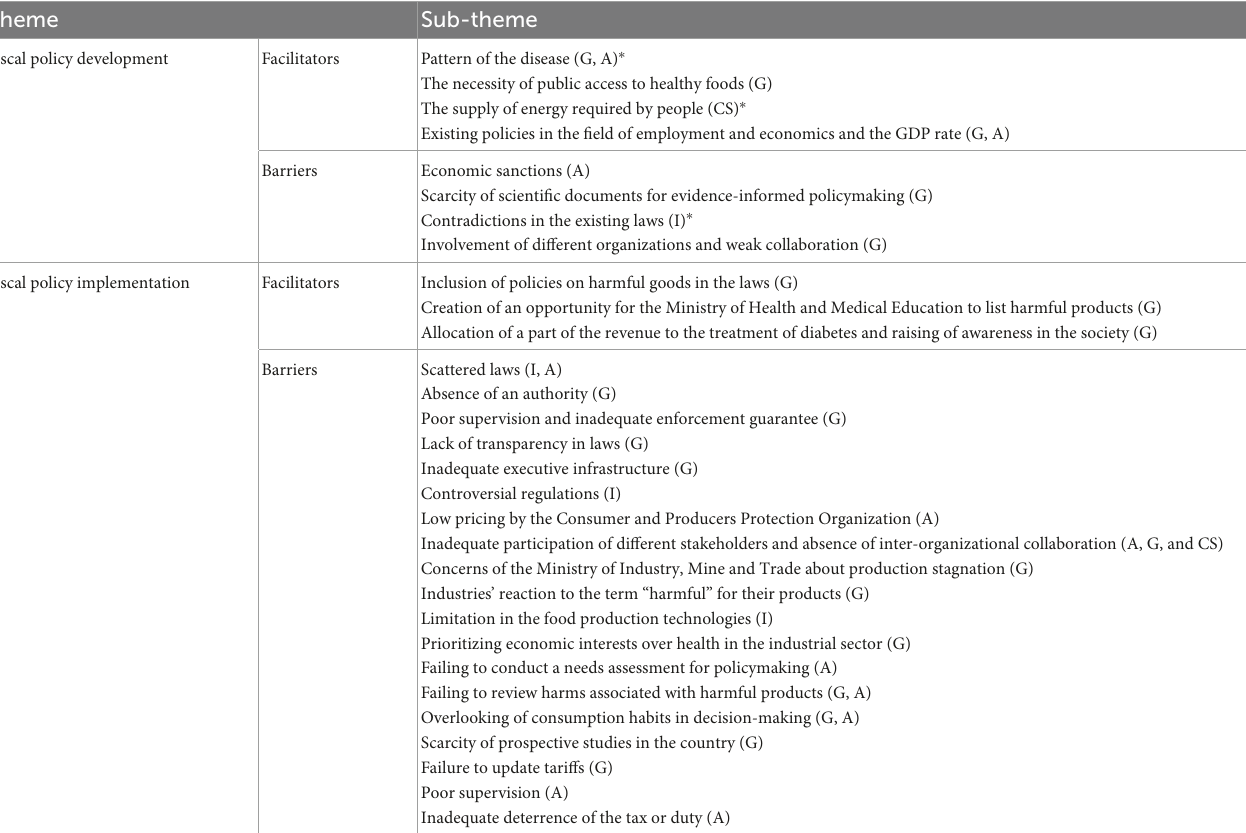
TABLE 2 Themes and sub-themes extracted from the interviews regarding fiscal policies on carbonated soft drinks or SSBs in Iran.